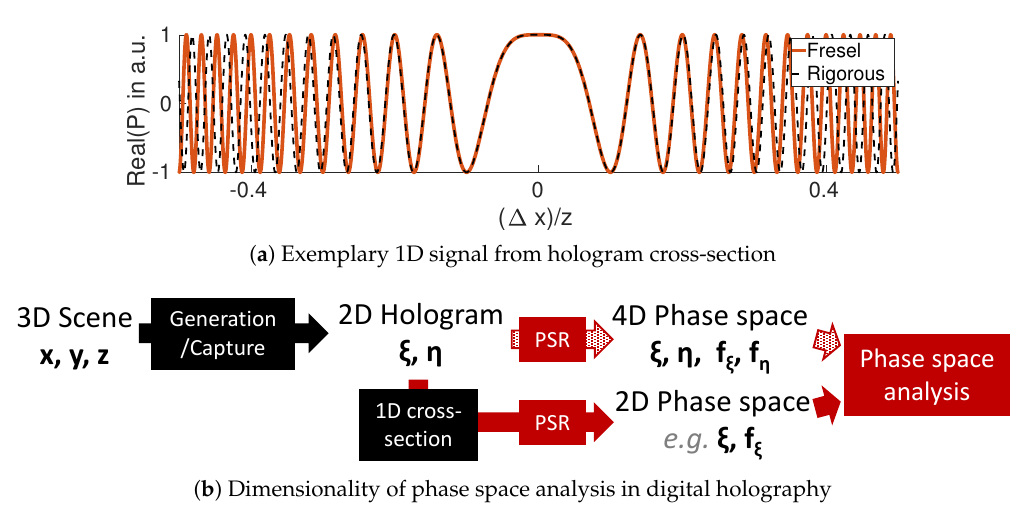
Figure 1. ( a ) Real part of a 1D point-spread function of a spherical (dashed, black; Rigorous form) and a quadratic wavefront (continuous, red; Fresnel approx.). ( b ) Application of phase space representations (PSR) to digital